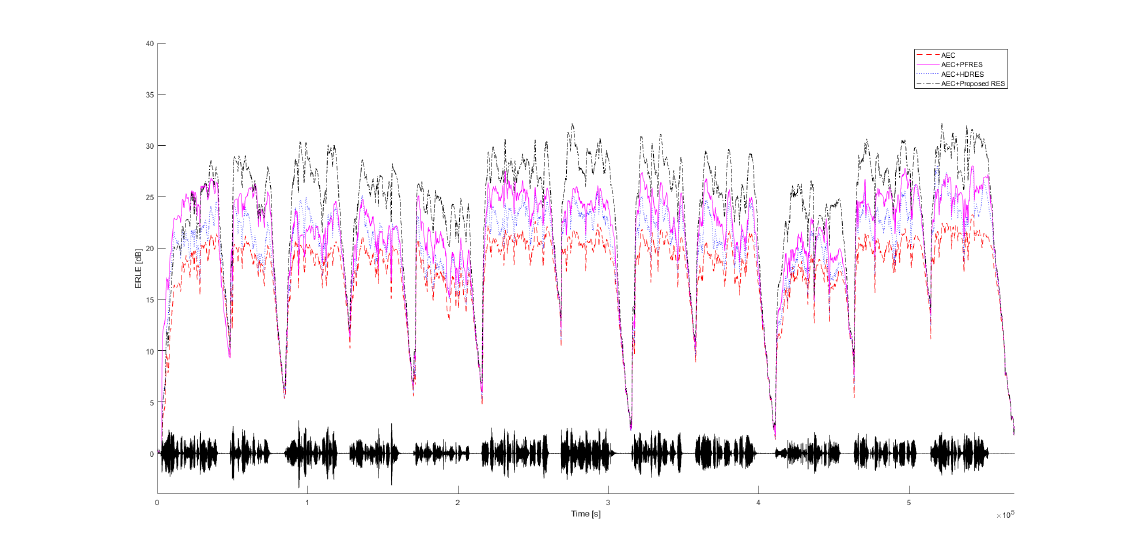
Figure 2. The ERLEs of the AEC system without RES, with PFRES, with HDRES, and with the proposed RES evolving with time and the microphone signal for one real-recorded signal with far-end single-talk without background noise. Table 3. ERLEs in various ENR conditions for the AEC, with the PFRES [27], with the HDRES [28], and with the proposed RES during the far-end single-talk periods for the real-recorded data. The numbers in the bold face indicate the best